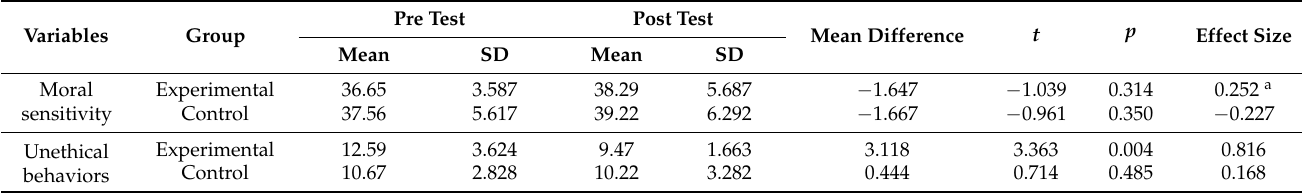
Table 4. Difference between pre and posttest in ethics